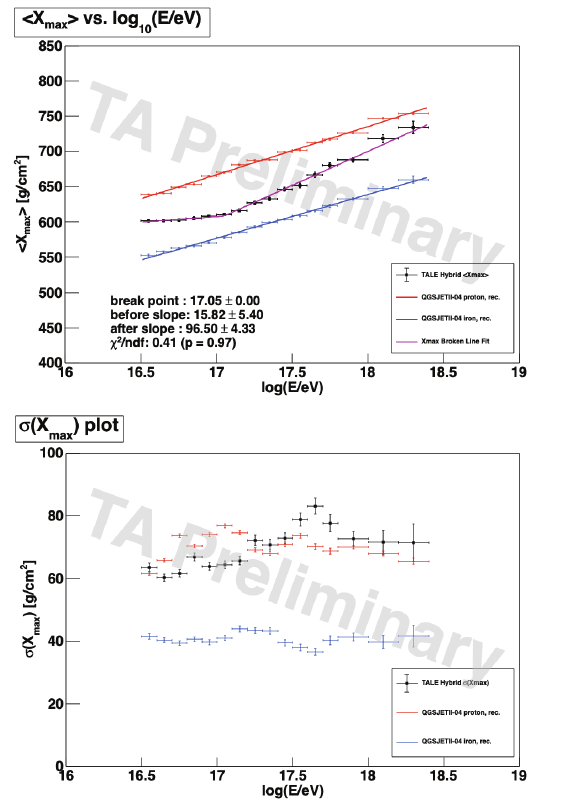
Table 2: Summary of systematic uncertainties on the X max measurements. Lines with multiple entries represent the values at the low and high end of the considered